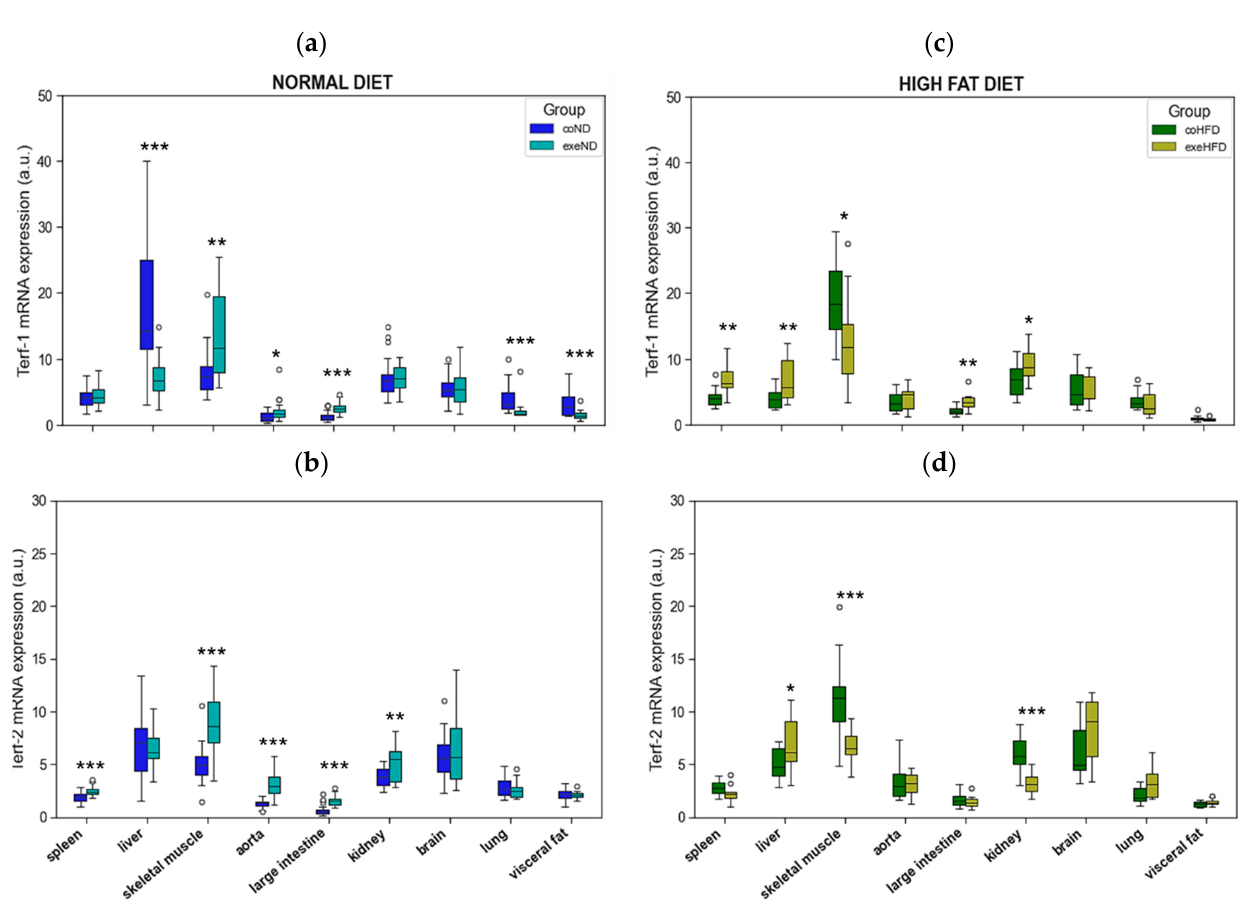
Figure 7. Comparison of TERF-1 and TERF-2 expression in nine solid organs from exercising and sedentary SD rats that received either normal diet or HFD for 10 months. ( a ) TERF-1 in sedentary lean animals (coND) vs. exercising lean animals (exeND), ( b ) TERF-2 in sedentary lean animals (coND) vs. exercising lean animals (exeND) ( c ) TERF-1 in sedentary obese animals (coHFD) vs. exercising obese animals (exeHFD), ( d ) TERF-2 in sedentary obese animals (coHFD) vs. exercising obese animals (exeHFD). Outliers are shown as white circles above the box plots. TERF-1 and TERF-2 mRNA expression is shown in arbitrary units. The two-tailed Student’s t -test or the Mann–Whitney U-test were used for group comparison of independent samples. * p < 0.05; ** p < 0.01; *** p < 0.001 vs. respective sedentary controls.